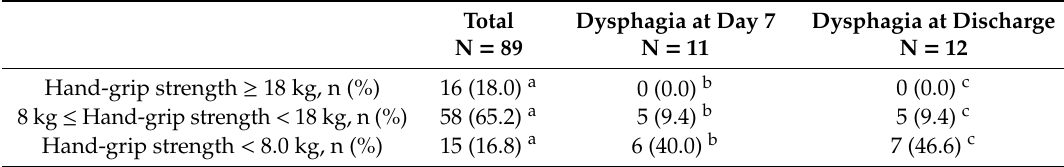
Table 3. Incidence of dysphagia in di ff erent groups stratified by hand-grip